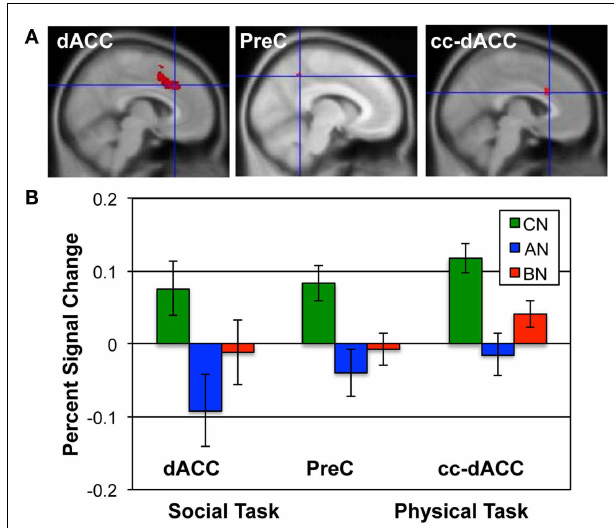
FIGURE 2 | ROIs and the percent signal change in each group for the Social and Physical Identity contrasts . (A) The upper row shows the extent of each ROI in red; from left to right, the dACC (MNI x = 6; Social Identity Reflected–Self); the precuneus ( x =− 8; Social Identity Self–Friend); and the cc-dACC ( x =− 6; Physical Identity Self–Friend). (B) The bar graphs shows the average percent signal modulation within each ROI for the CN (green), AN (blue), and BN (red) groups. Percent signal change was computed for the contrast and task that defined each ROI; the Social Identity task for both the dACC and PreC; the Physical Identity task for the